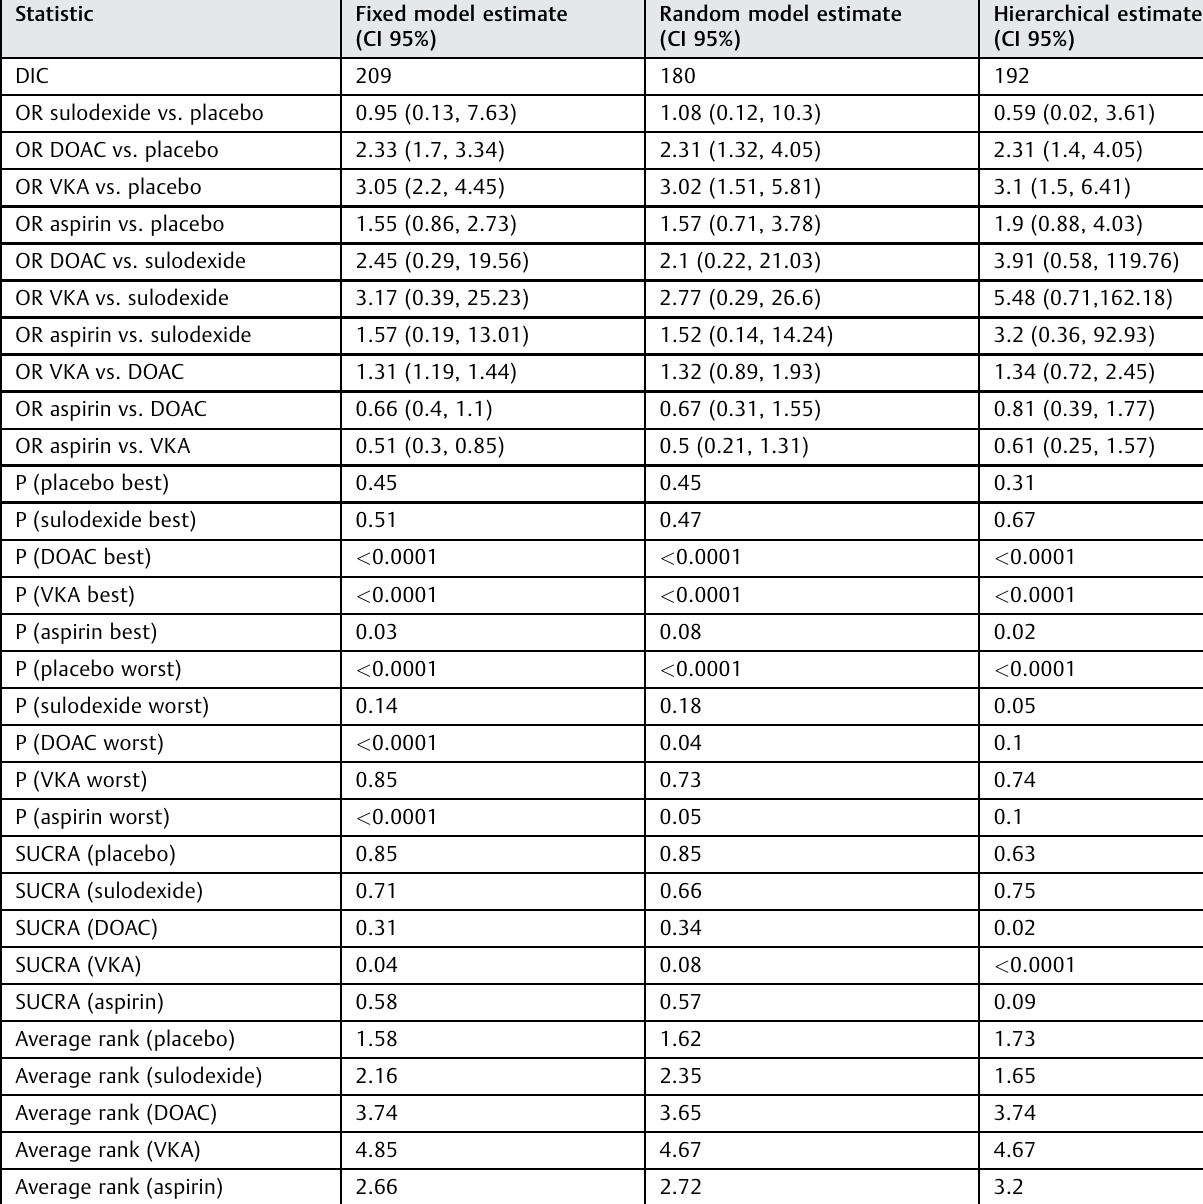
Table 4 Main results for clinically relevant nonmajor bleeding, all studies